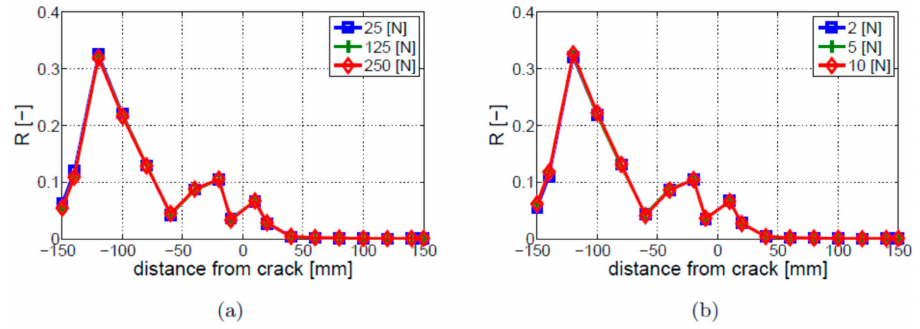
Figure 6. Parametric study of excitation amplitude for the bi-linear crack model and different amplitude levels of ( a ) vibration LF excitation; ( b ) ultrasonic HF